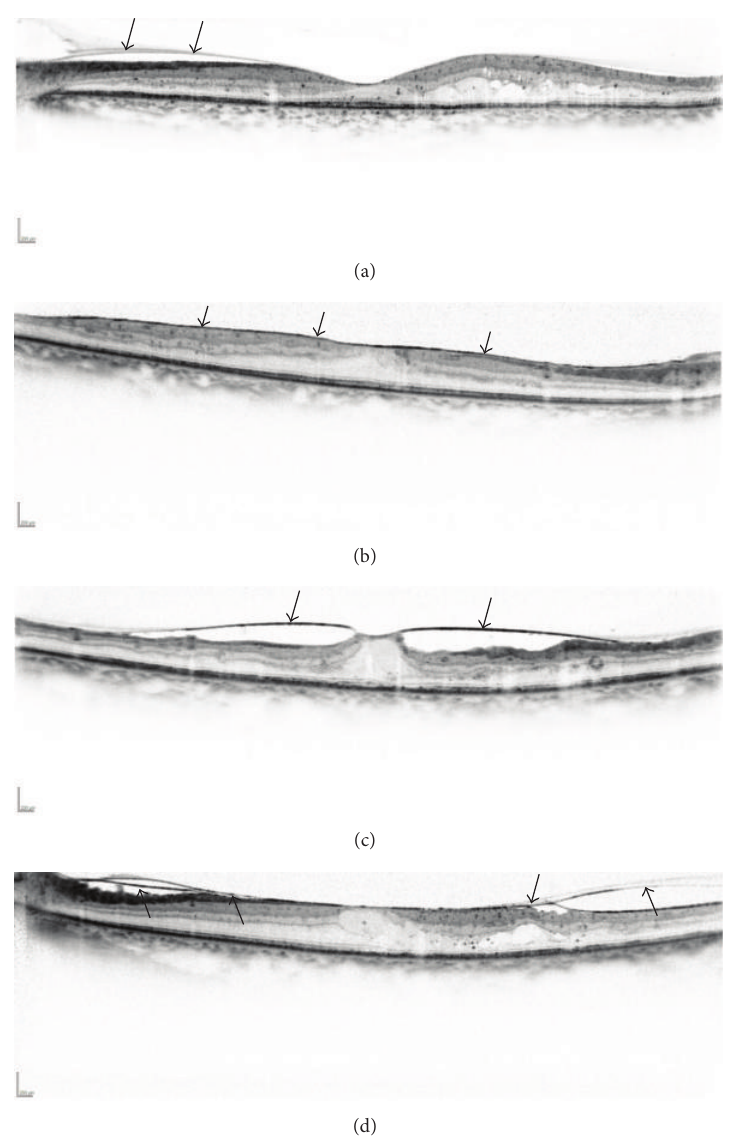
Figure 4: Several patterns of vitreomacular interface abnormalities in DME. (a) A posterior hyaloid membrane is sometimes depicted on OCT images (arrows). (b) ERM often is accompanied by sponge-like retinal swelling (arrows). (c) A perifoveal vitreous separation sometimes induces vertical traction, as in idiopathic macular holes (arrows). (d) Some eyes have separation of a posterior vitreous membrane